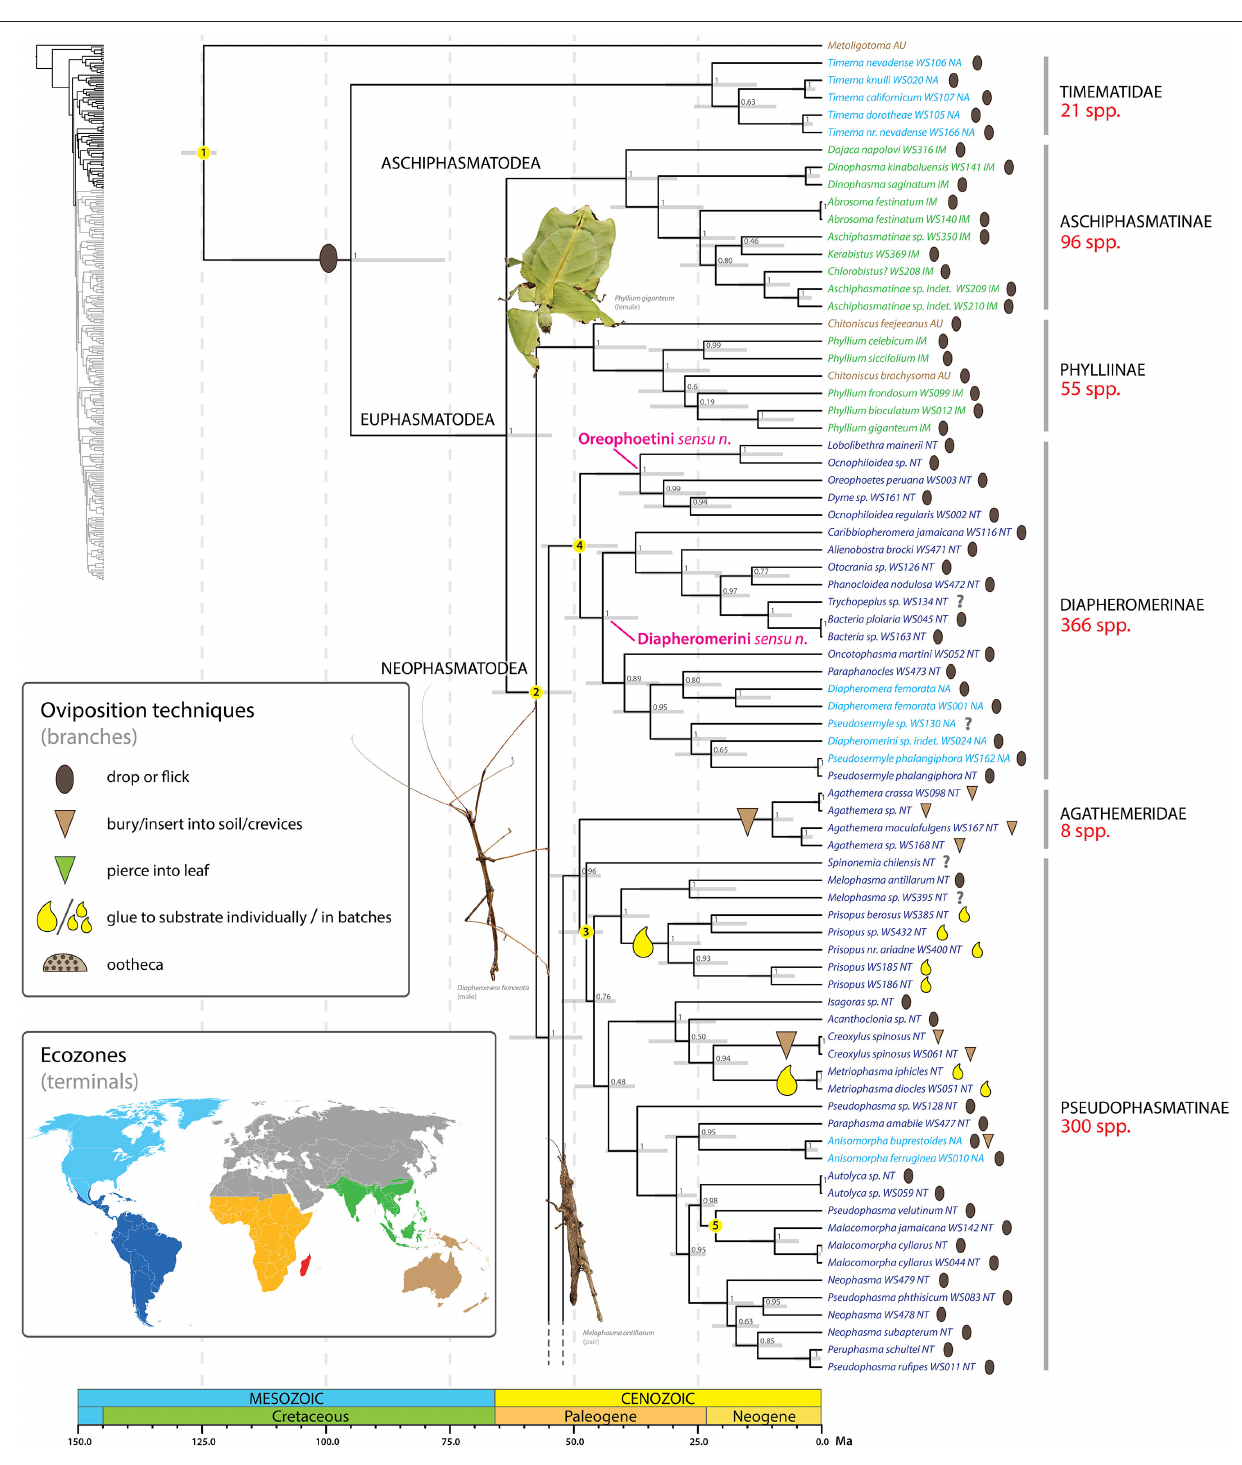
Frontiers in Ecology and Evolution | www.frontiersin.org